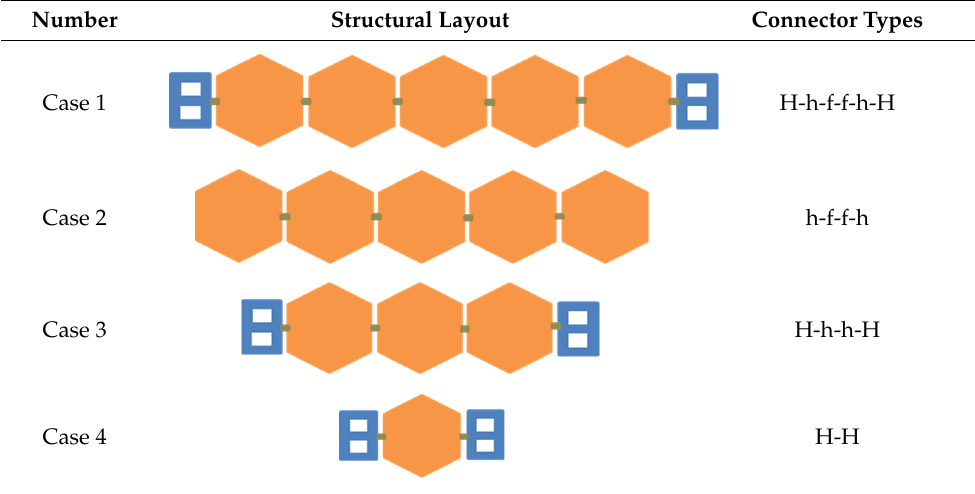
Figure 11. Main motion responses of the first head-wave hexagonal module under different layouts: ( a ) surge; ( b ) heave.